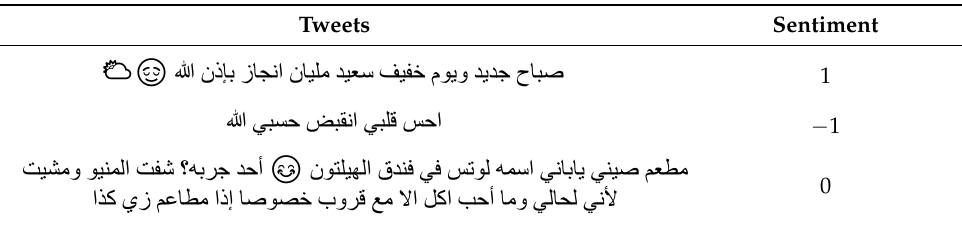
Table 1. Examples of annotated tweets in the period before COVID-19.